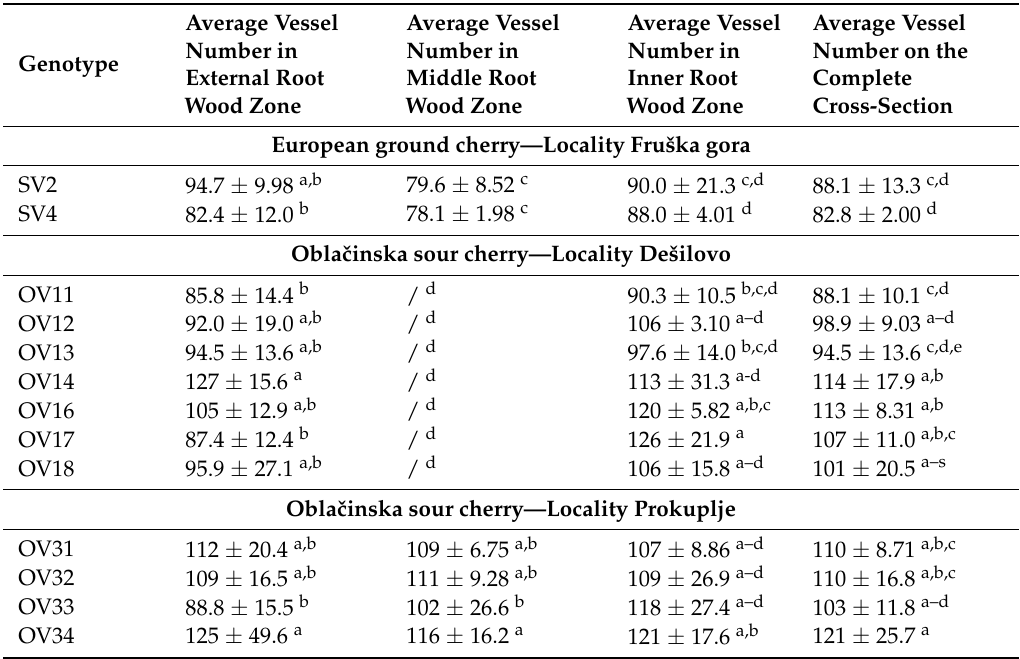
Table 4. Average vessel number of different secondary root zones and complete cross-sectional area. Average Vessel Average Vessel Genotype